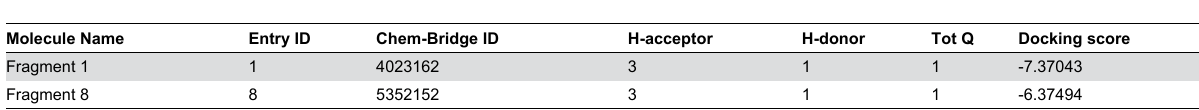
Table 3. Detailed structures and docking information for Fragment 1 and Fragment 8.